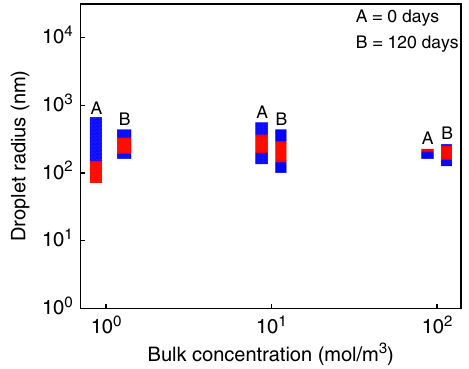
Fig. 4 Emulsion stability over a period of 120 days. Long-term measurements of peak radii and polydispersities of nanoscale emulsions formed using water condensation on different concentrations of Span 80 in dodecane for condensation time of 2 min. Bars marked A show DLS data taken the same day the emulsion was made, or 0 days after the emulsion was formed; bars marked B show DLS data taken 120 days after the emulsion was formed. Red region: peak droplet radius ± one standard deviation; blue region: range of minimum to maximum droplet size detected. The raw DLS measurements for droplet sizes corresponding to 120 days is shown in supporting information (Supplementary Fig.